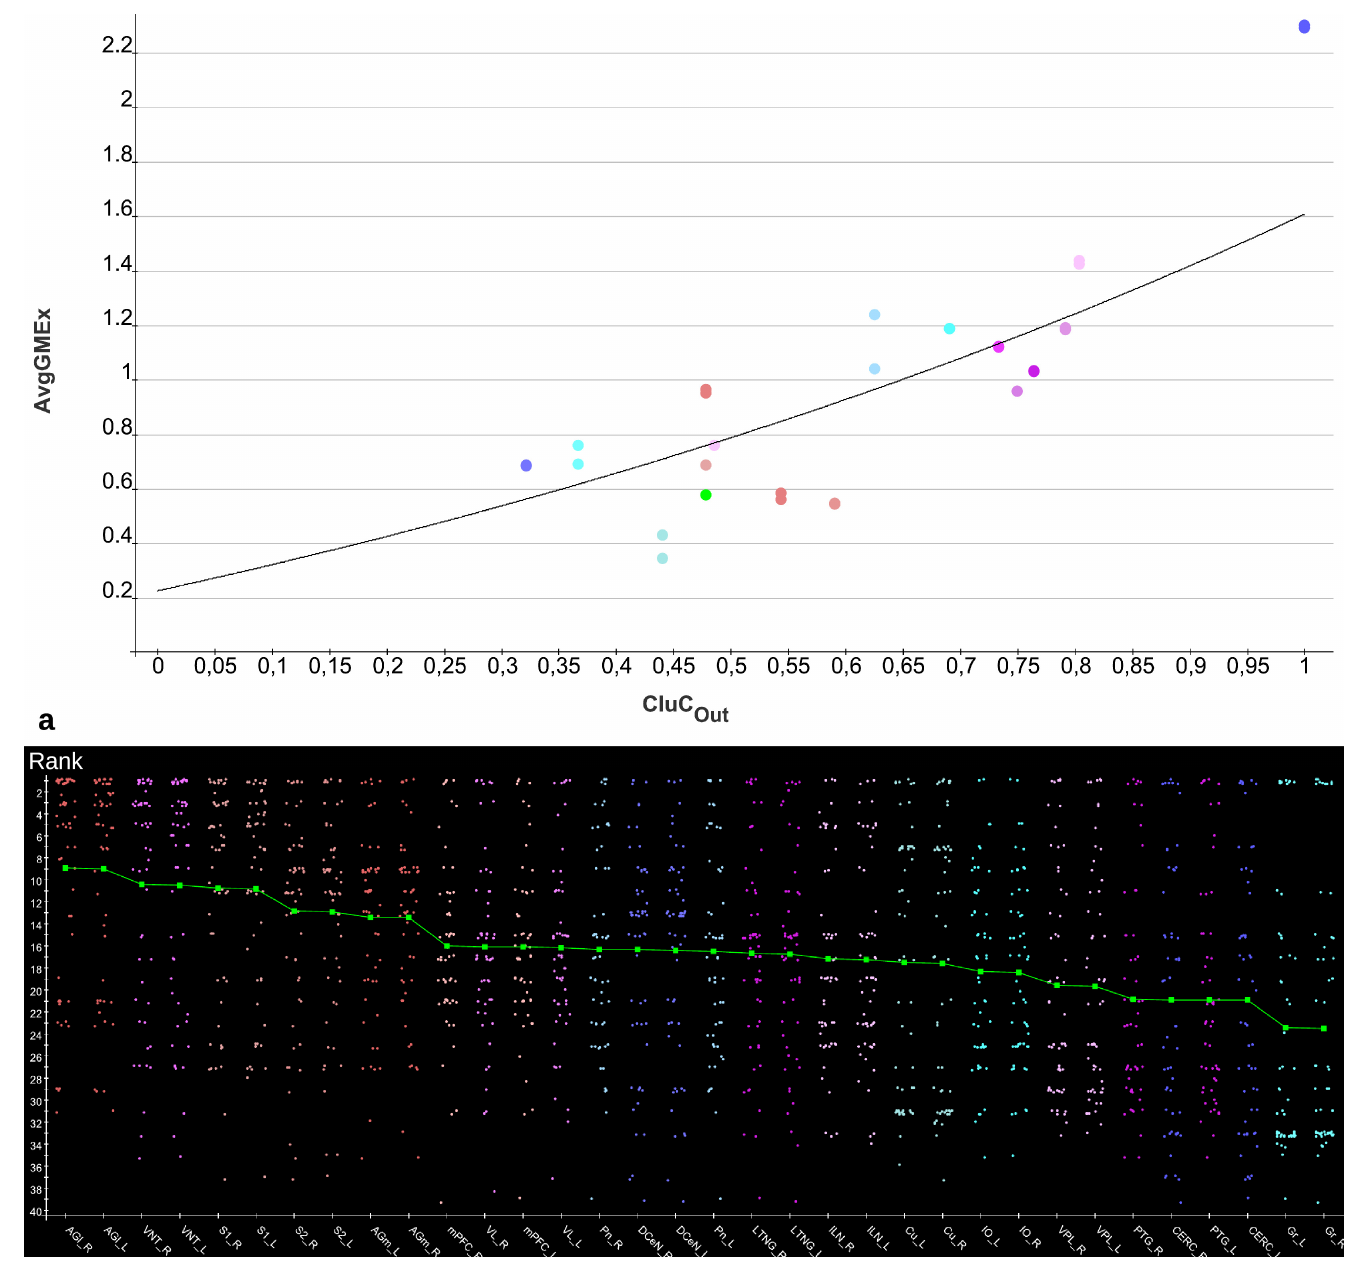
( DG in ) Out DG a ll